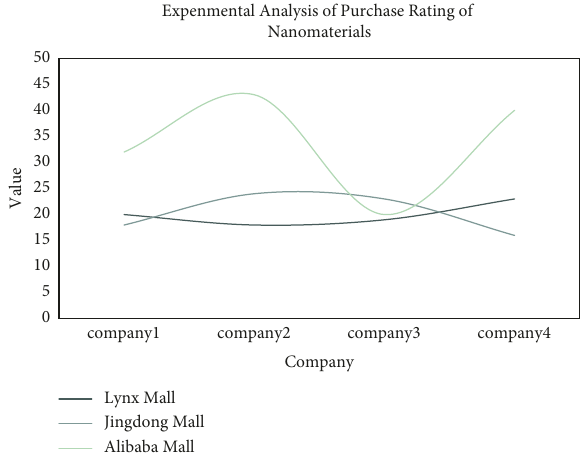
Figure 4: Experimental analysis of purchase rating of